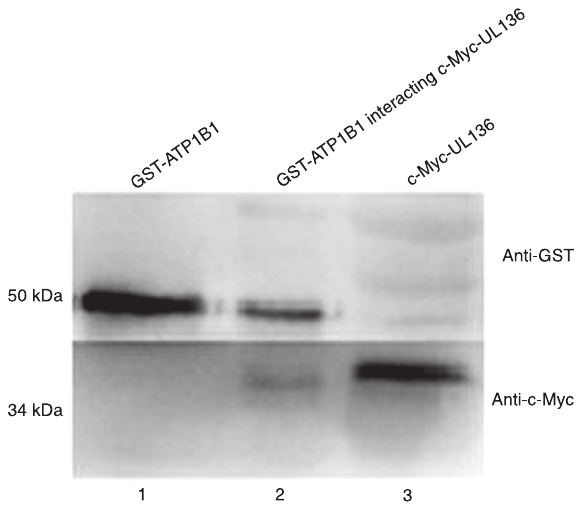
Figure 1. Result of a pull-down experiment analyzed by Western blot. The upper part of the figure was reacted with a goat anti- GST monoclonal antibody, and the lower part was reacted with a mouse anti-c-Myc monoclonal antibody, separately. Lane 1 shows the protein lysates of transfected DH5α expressing GST- ATP1B1 bait protein. Lane 2 shows interaction between c-Myc-